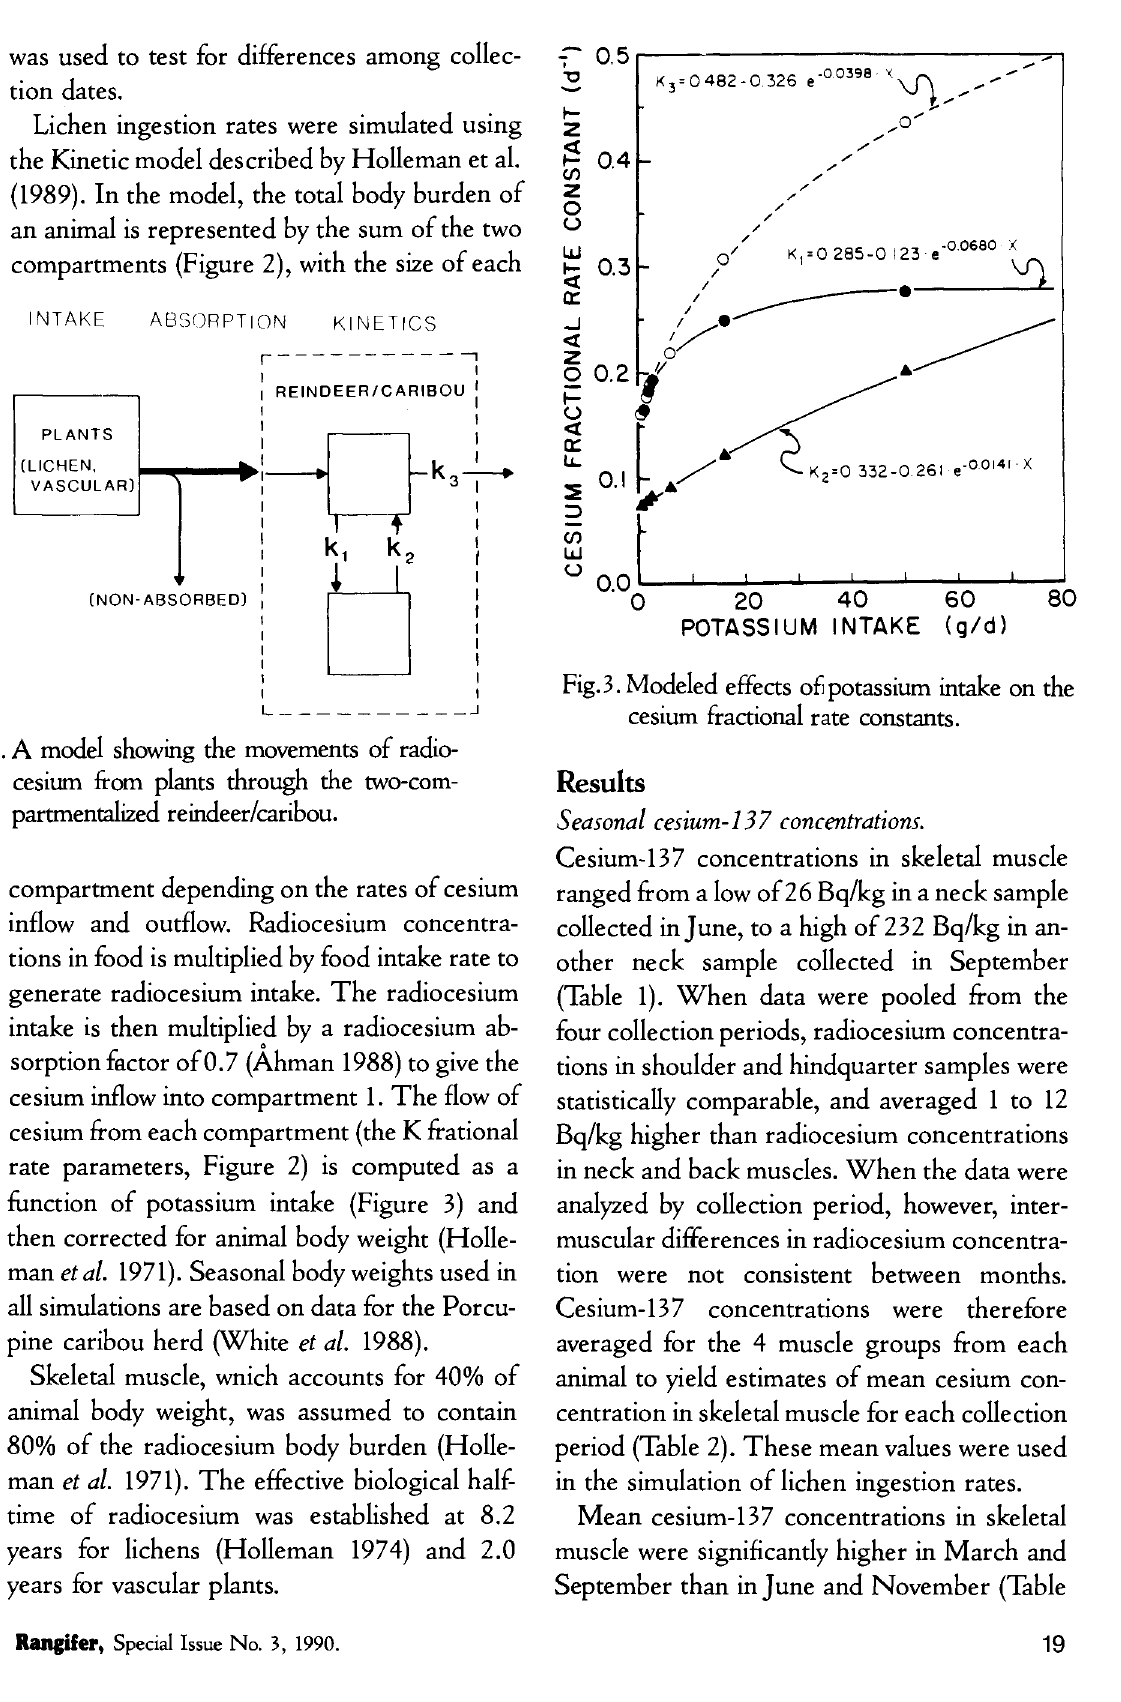
1.2. A model showing the movements of radio-